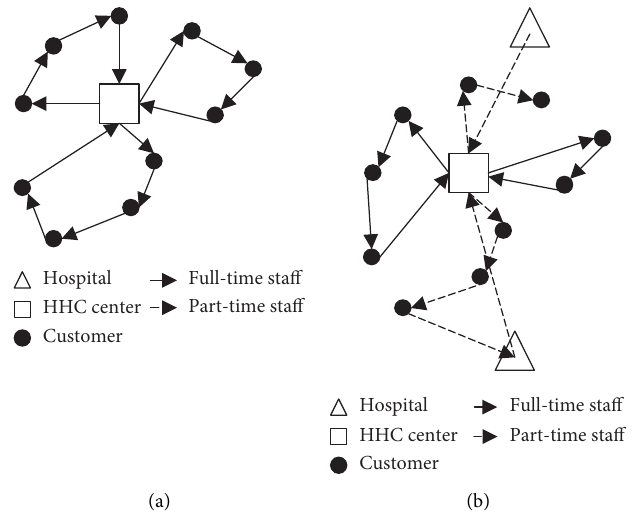
Figure 1: Schematic diagram of (a) traditional mode and (b) resource sharing